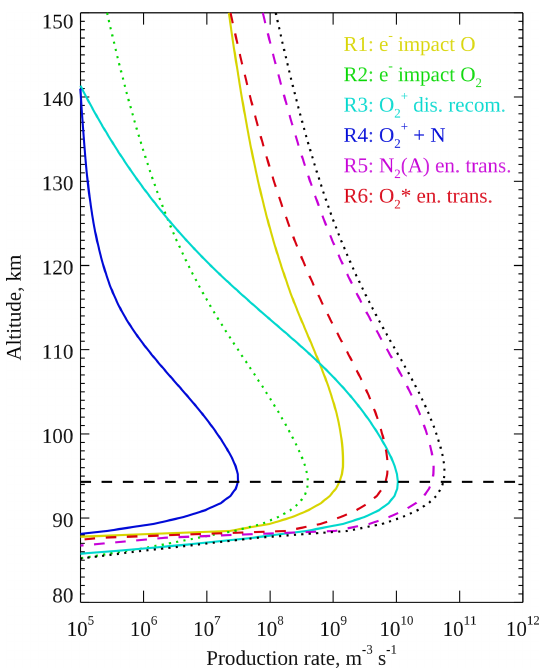
Figure 11. Modelled production rate profiles of O( 1 S ) after 12s of Gaussian electron precipitation at 25keV. The reactions producing O( 1 S ) are listed in Table 2. The rates of Reactions (R1), (R2), (R3), (R4), (R5), and (R6) are plotted by solid yellow, dotted green, solid cyan, solid blue, dashed magenta, and dashed red lines, respectively. The total production rate of O( 1 S ) is shown by the dotted black line. The horizontal dashed line marks the peak height of the blue 427.8nm emission.